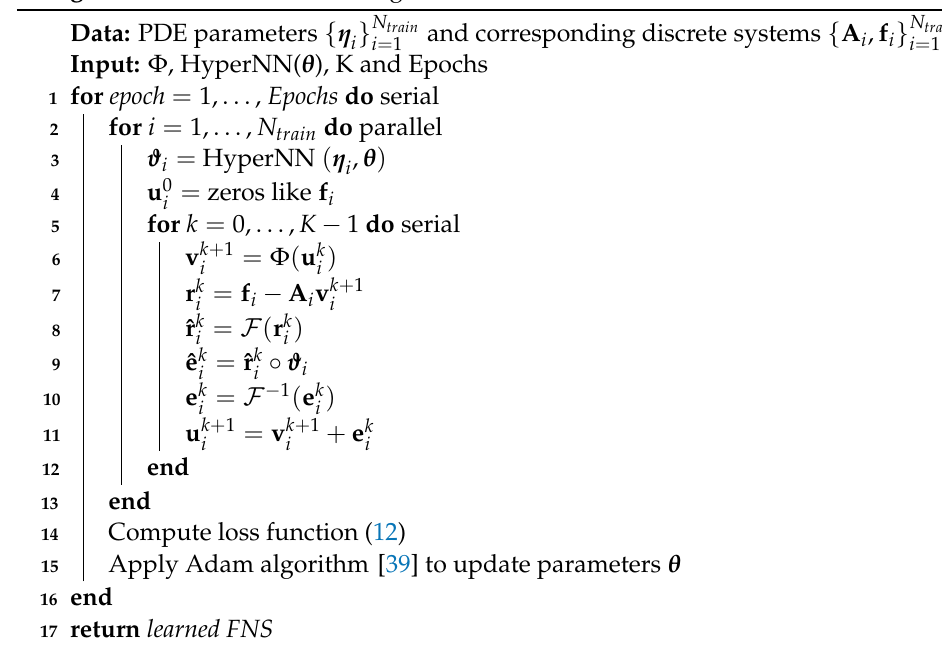
Algorithm 1: FNS offline traning.